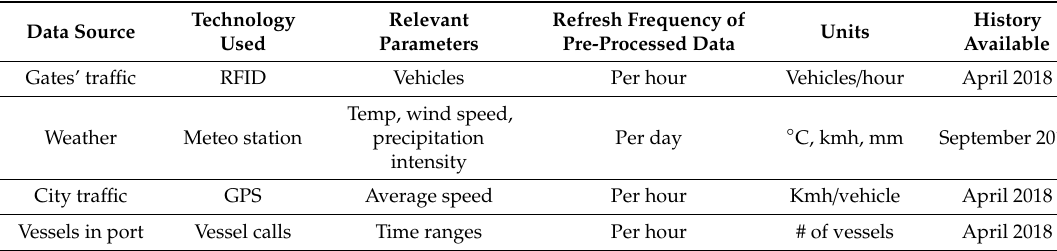
Table 3. Summary of data used in the experiment.